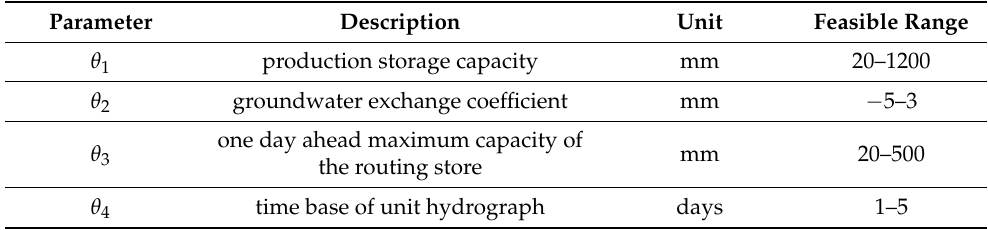
Table 1. Description of the parameters within the GR4J model.